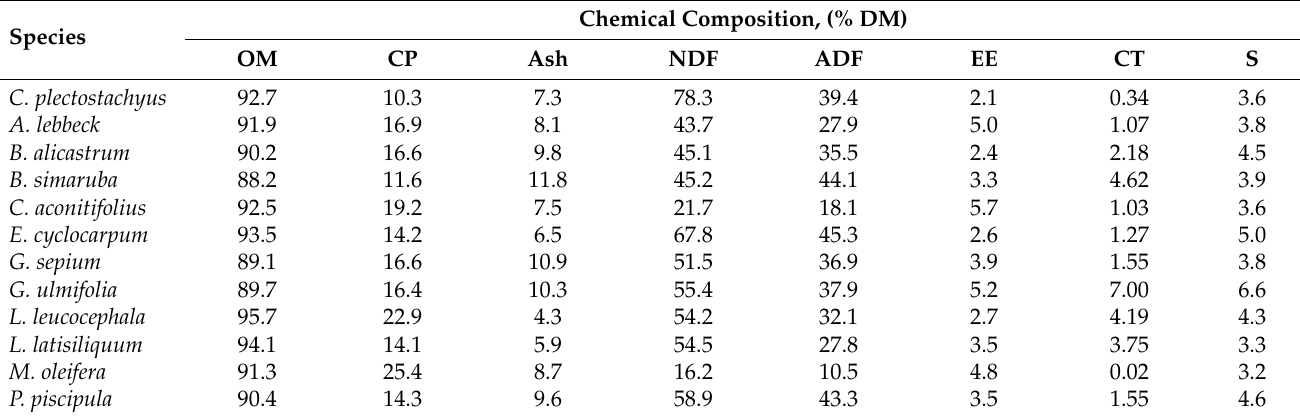
Table 1. Chemical composition of the foliage of tropical trees and